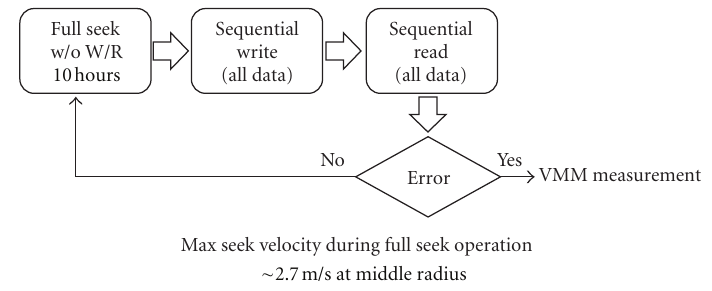
Figure 1: Sequence of drive test accelerated by OC. The fly condition is passive (no dynamic flying height control) during the full stroke seek operation without write/read operation.